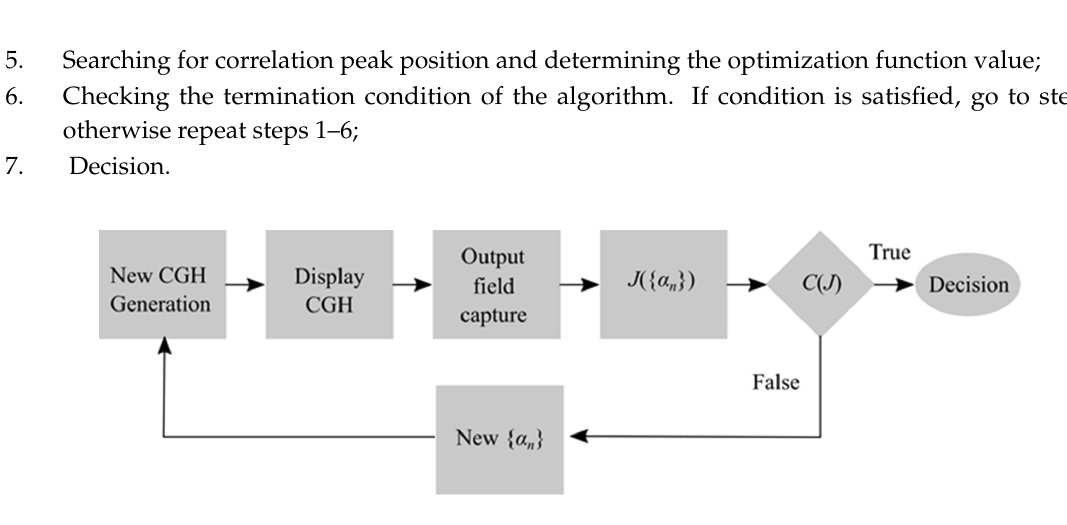
Figure 1. Block diagram of the algorithm for measuring wavefront aberrations.